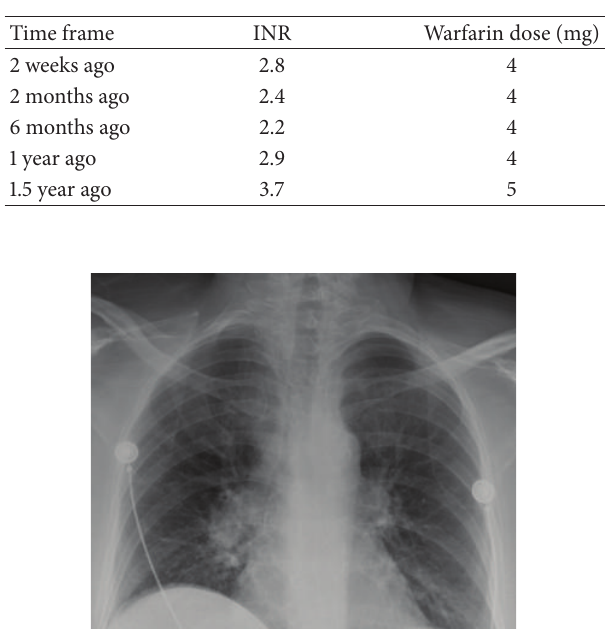
Table 2: Warfarin dosing and INR prior to hospitalization.